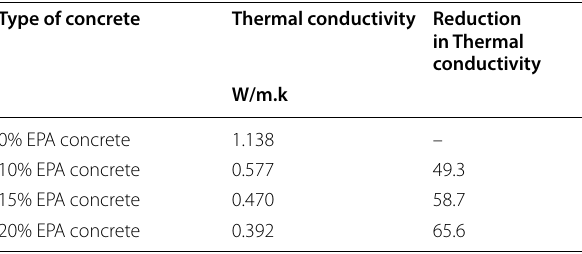
Table 5 Thermal performance data of the concrete